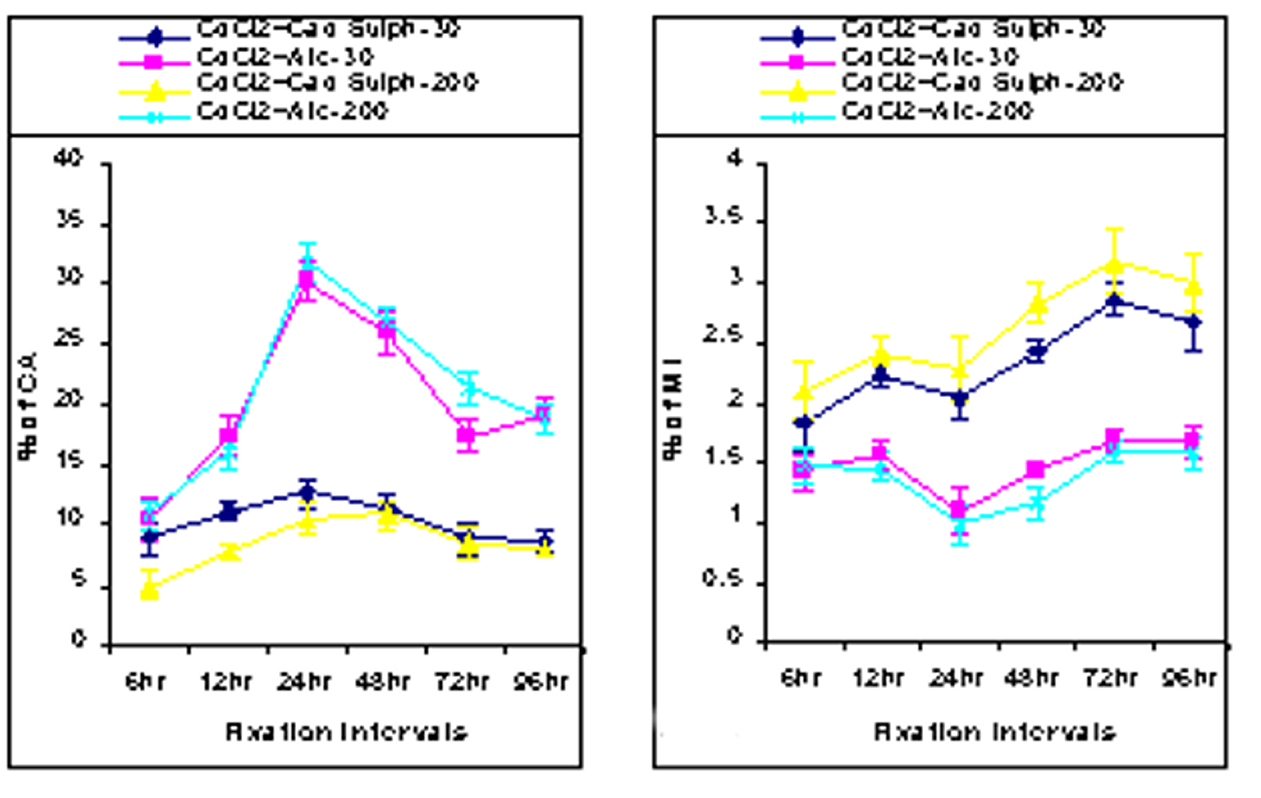
Figure 10 Showing time-dependent frequencies of Cad Sulph-30 com- bined pre- and post-fed and Cad Sulph-200 combined pre- and post-fed series versus their respective CdCl 2 treated alcohol-30 and alcohol-200 control mice. Chromosome aberration (CA)-9; Mitotic index (MI)-10; Micronucleated erythrocytes (MNE)-11 and Sperm head anomaly (SHA)-12.